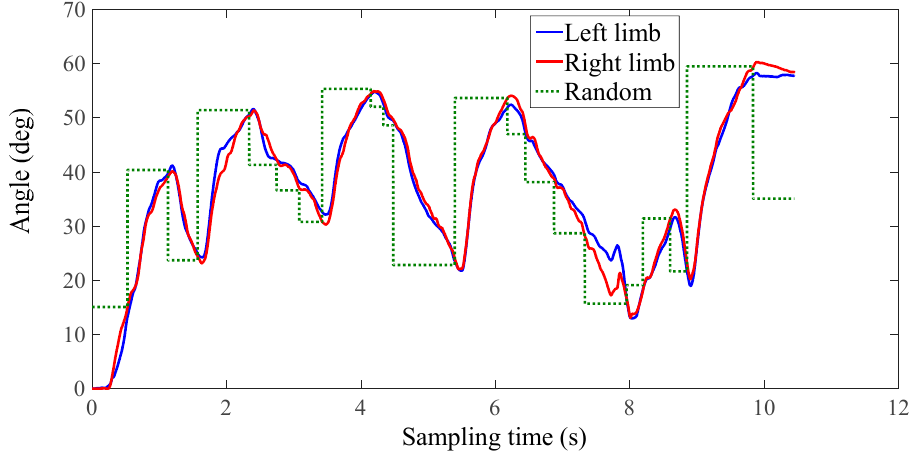
Figure 13. With tactile feedback (the third group, subject one).